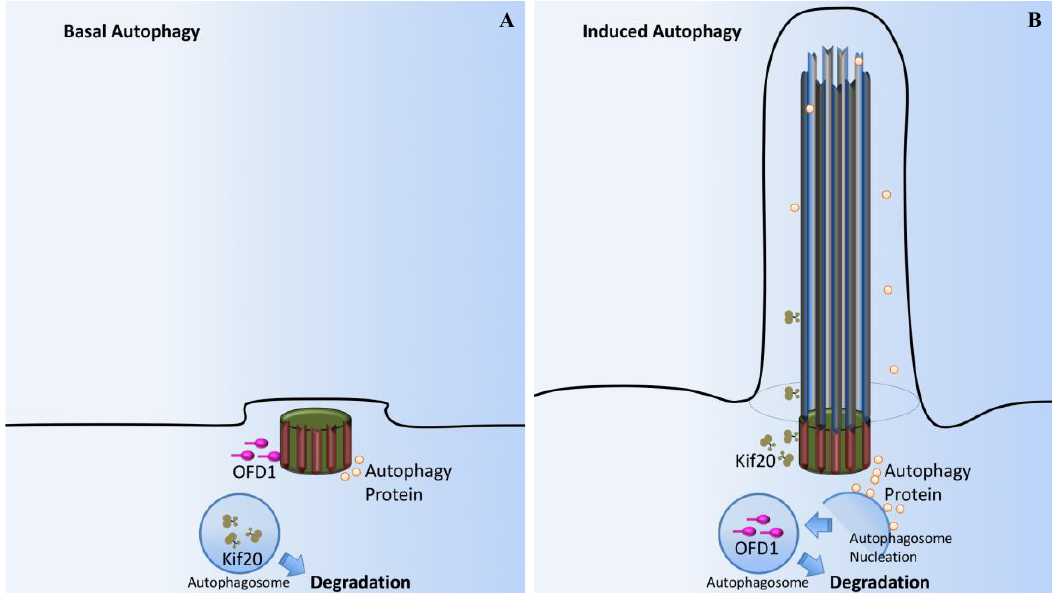
Figure 9. Cilia-dependent OFD1/Autophagy signaling. ( A ) In basal autophagy, ciliogenesis is prevented by the sequestering of IFT20 in autophagosomes and its autophagic degradation. OFD1, a protein that constrains cilium formation at centriolar satellites, is not affected by basal autophagy and ciliogenesis is therefore impaired. ( B ) Autophagy induced by serum deprivation promotes ciliogenesis through inactivation of OFD1, while sparing IFT20. Autophagy proteins are also confined to this sensory organelle, probably contributing to cilium organization. At the basal body, signals from the cilium stimulate autophagosome nucleation and OFD1 degradation.